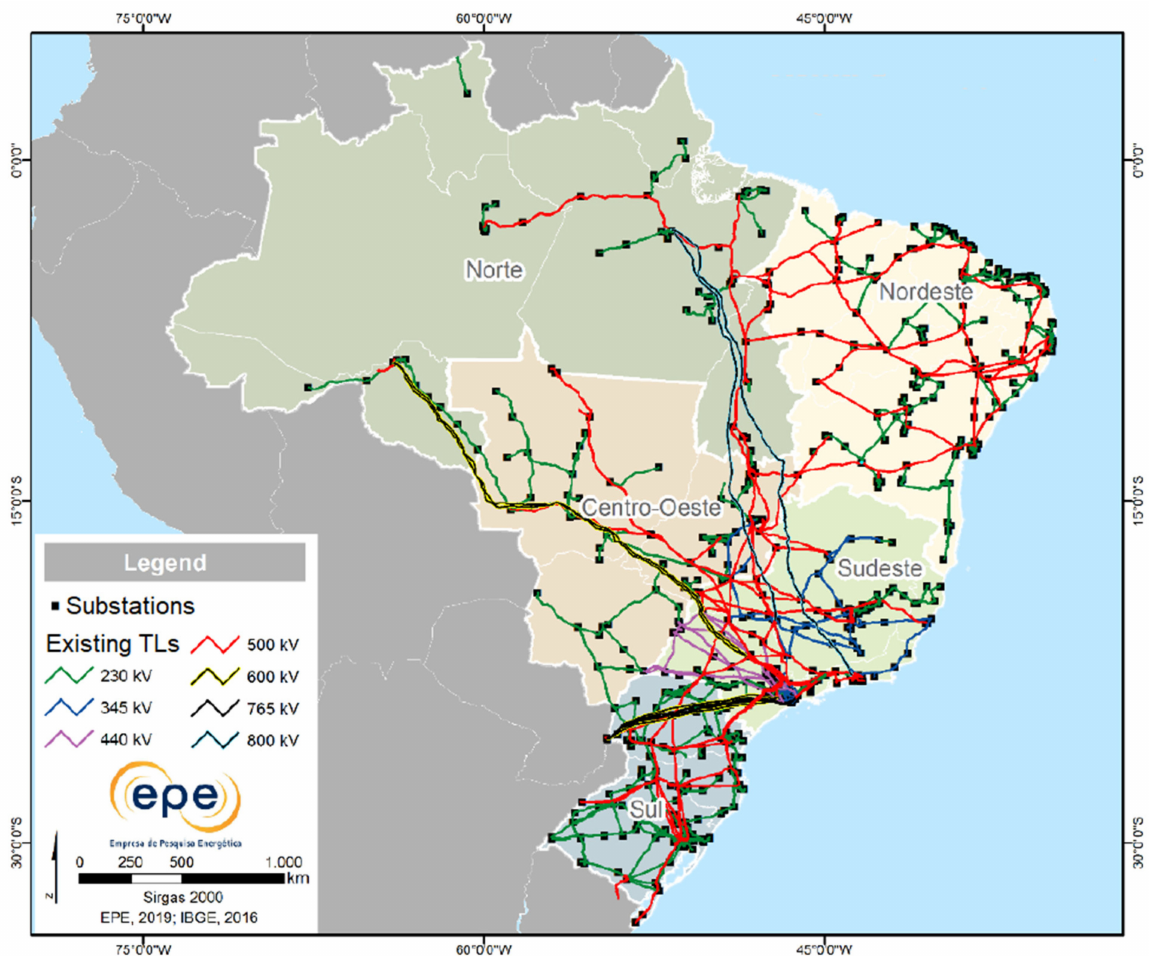
Figure 5. Brazilian National Interconnected System (NIS) Map 2019 (adapted from